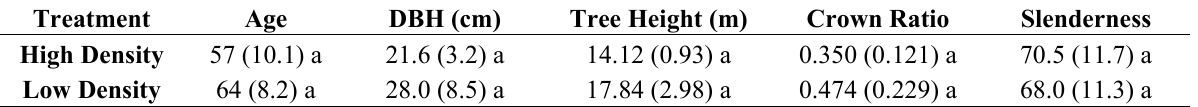
Table 1. Average (standard deviation) age, DBH, tree height, crown ratio and slenderness of red pine in the Huron National Forest, Michigan, between two density types. Different letters denote significant differences between density types ( p < 0.05).